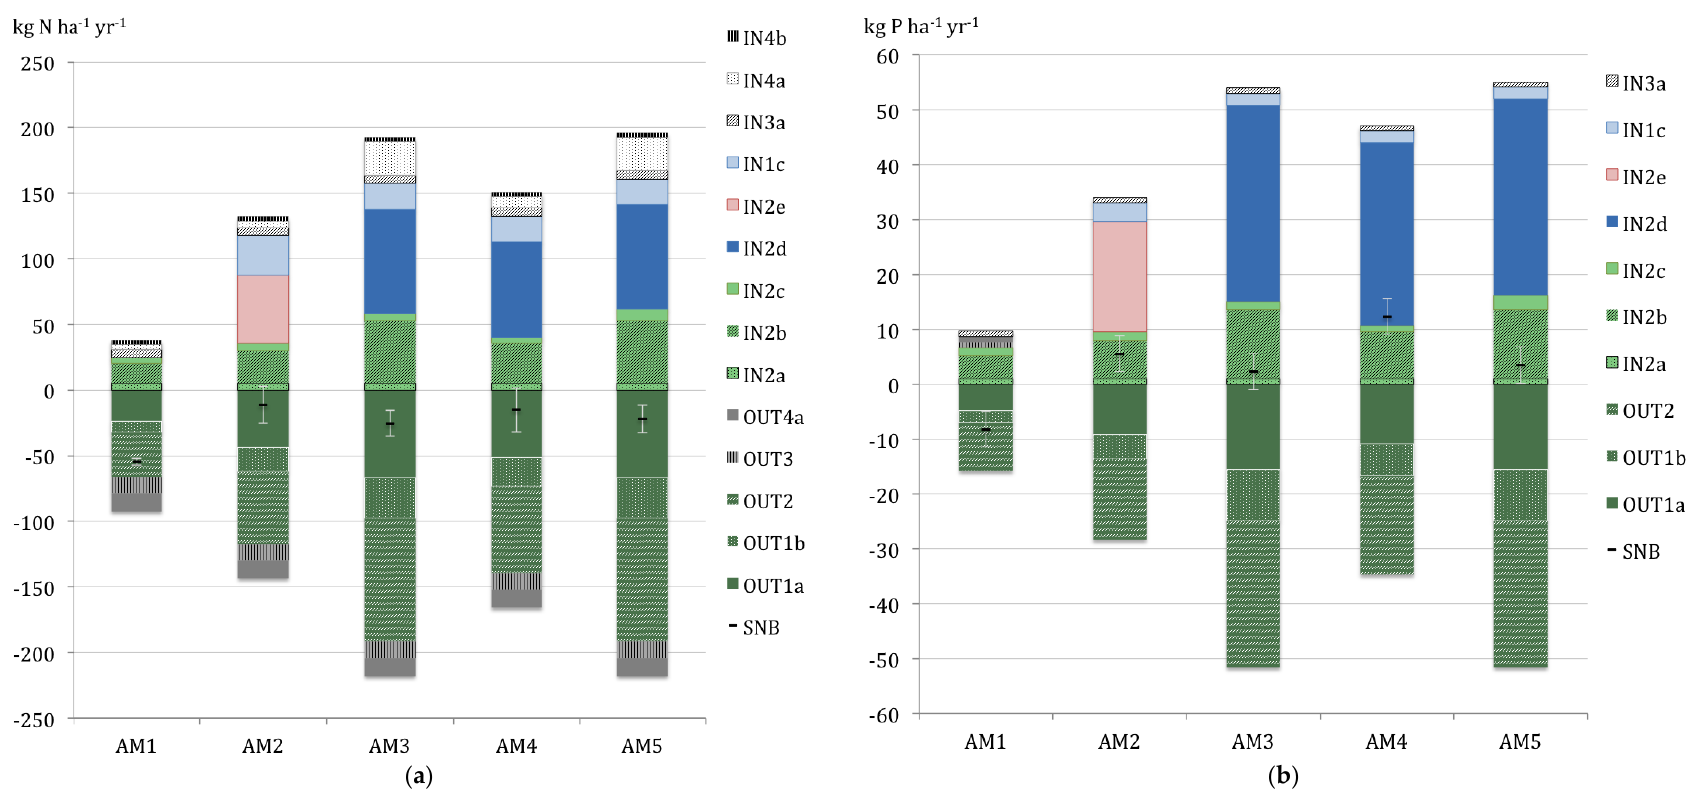
Figure 3. The estimated SNB II for N ( a ); left) and P ( b ); right) comprises natural input (IN3a, 4a, 4b) and natural output (OUT3, 4a) flows; organic (IN2a-2e) and mineral (IN1c) input flows; and output flows (Out1a, 1b, 2) with agricultural products. Mean values for the estimated SNB II are indicated with black dashes; standard errors of the means with grey error bars. Scenarios are defined in Table 1; the IN and OUT flows are in Table 3. Plot data is provided in Supplementary Table S12.